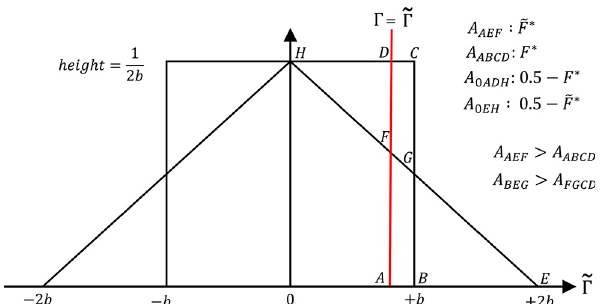
Figure 2 Probability density functions of employer-provided parking without and with